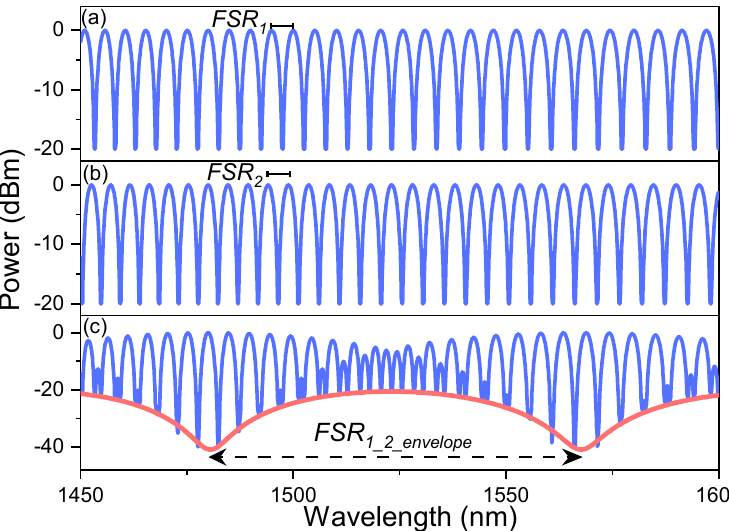
Figure 1. Interference patterns of ( a ) interferometer 1 and ( b ) interferometer 2, ( c ) the superposition of the two output signals ( FSR 1 ~ FSR 2 ), using the Vernier effect in a series configuration.